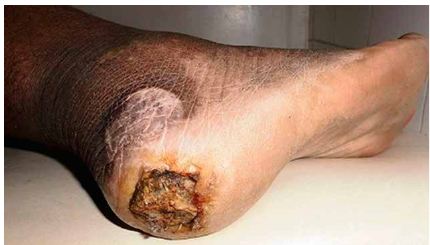
Figure 3: Ulcerous lesion of the right heel (archive of the Department of Dermatology, Joseph Raseta Befelatanana University Hospital, Antananarivo,